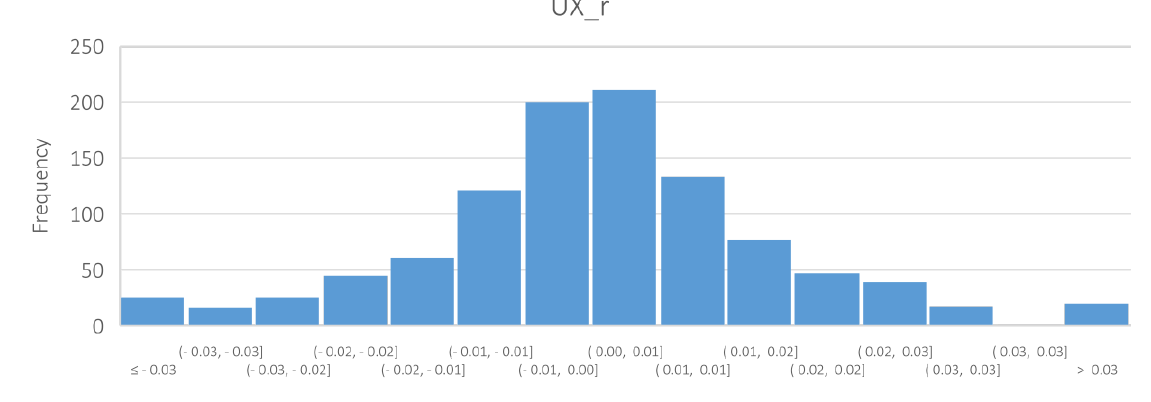
Figure A2. Frequency of returns for the case of the UX